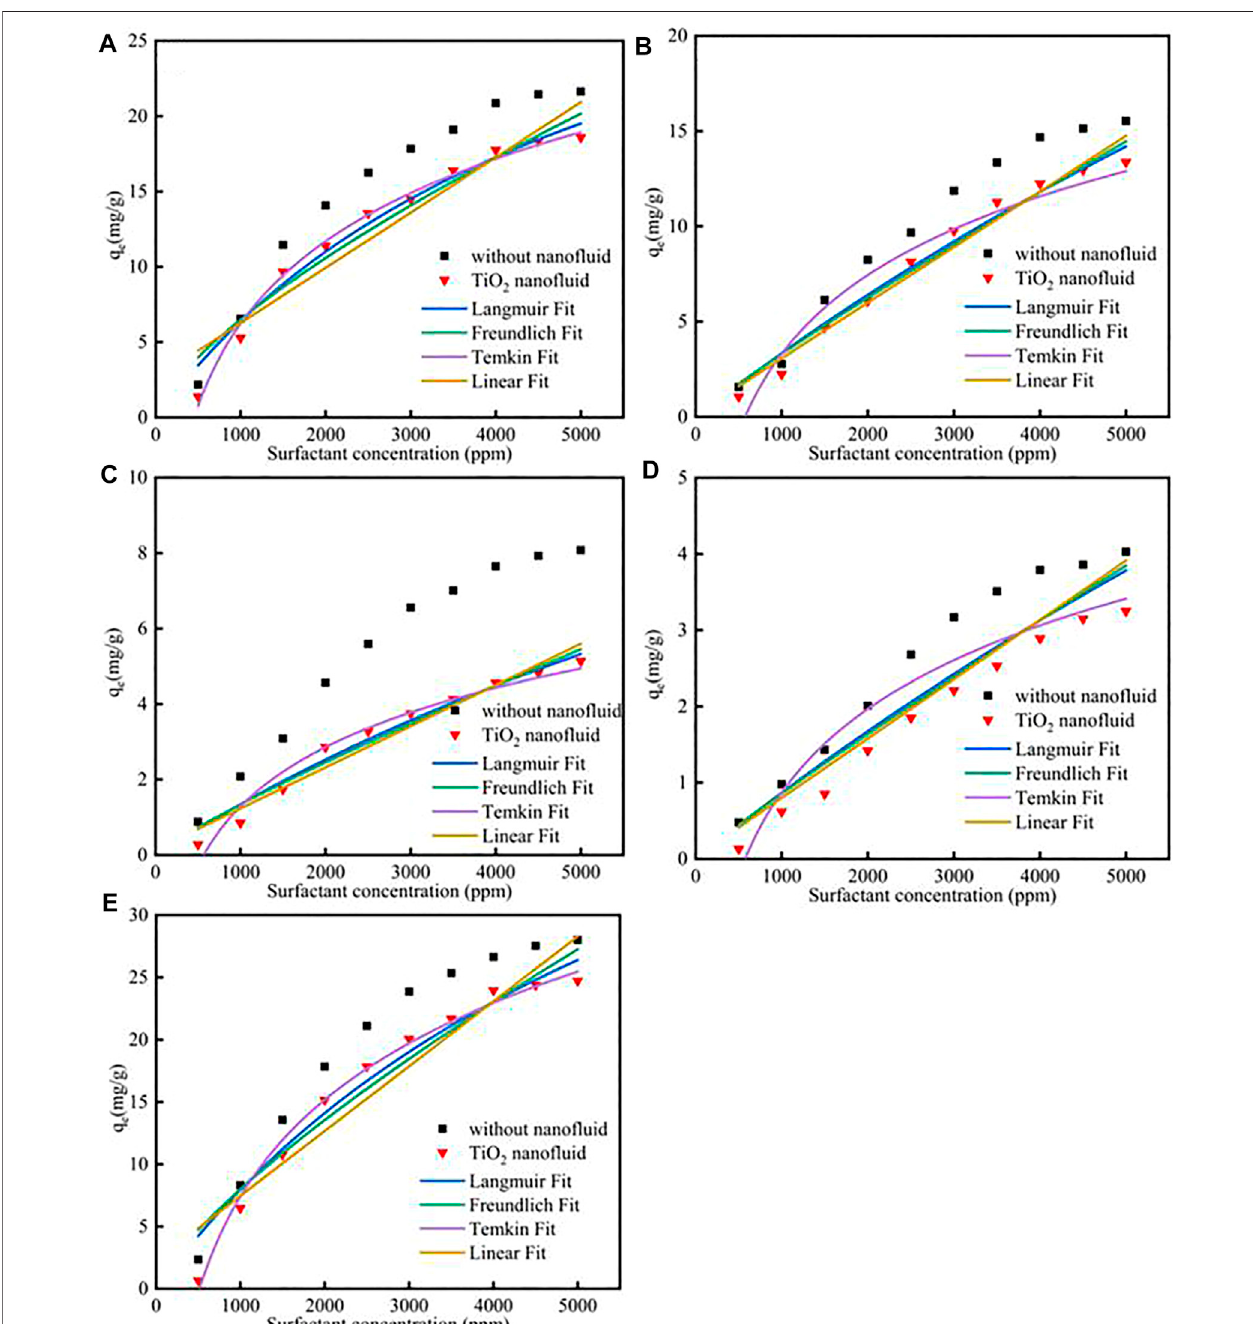
FIGURE5| Differentsurfactants (A) CTAB, (B) SDS, (C) TX-100, (D) sophorolipid, (E) rhamnolipid withTiO 2 nanoparticles adsorption oncarbonate rock at 298 K.